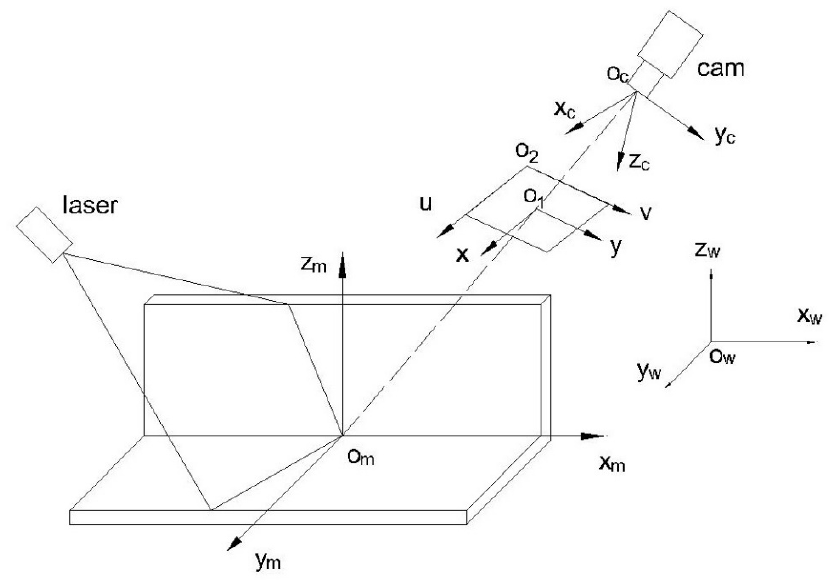
Figure 4. A 3D reconstruction model of the linear structured light.